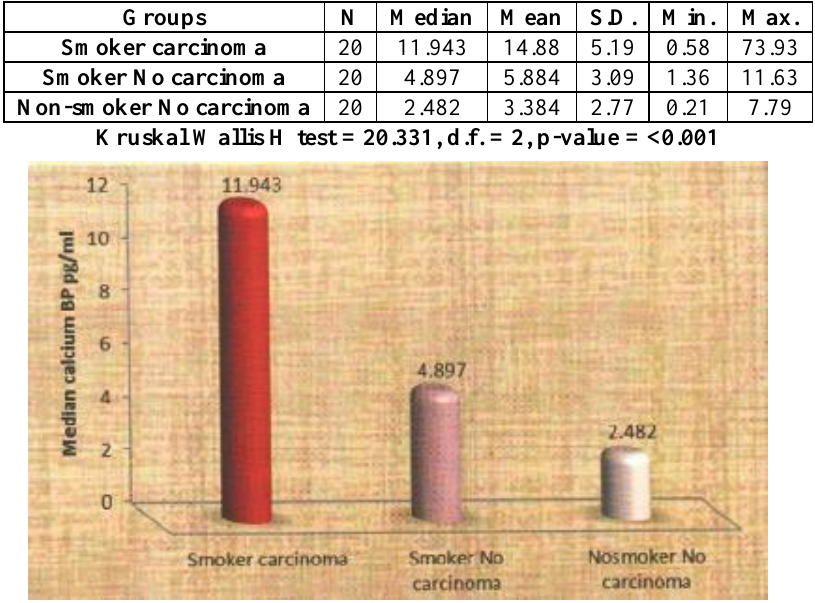
Table 1: Descriptive statistics of calcium BP in the three study groups